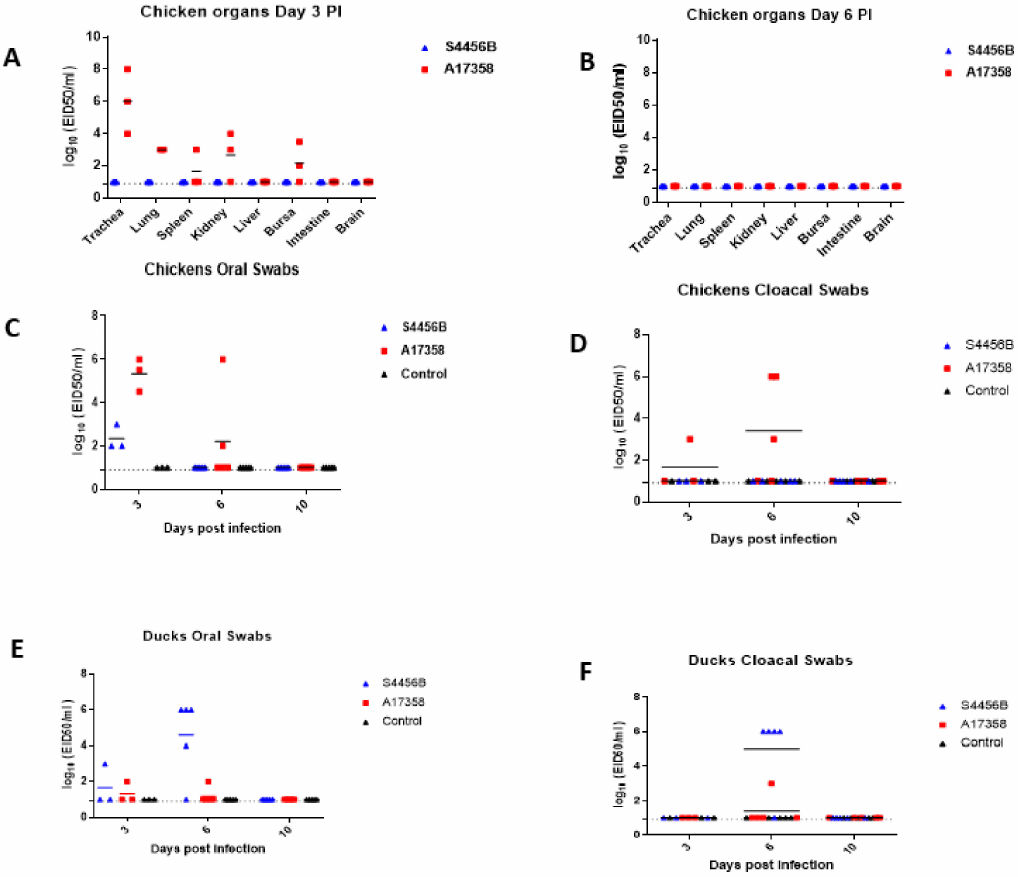
Figure 5. Replication of the two forms of the Egyptian H9N2 virus in infected chickens and ducks. Replication of both viruses in different organs of infected chicken at days 3 PI ( A ) and 6 PI ( B ). Oral ( C ) and cloacal ( D ) swabs at days 3, 6, and 10 PI were titrated by EID50. Oral and cloacal swabs were collected from ducks infected with the two viruses and from a control group at days 3, 6, and 10 PI. Oral and cloacal swabs were titrated by EID50 ( E , F ), respectively. The limit of virus detection is indicated by the dotted